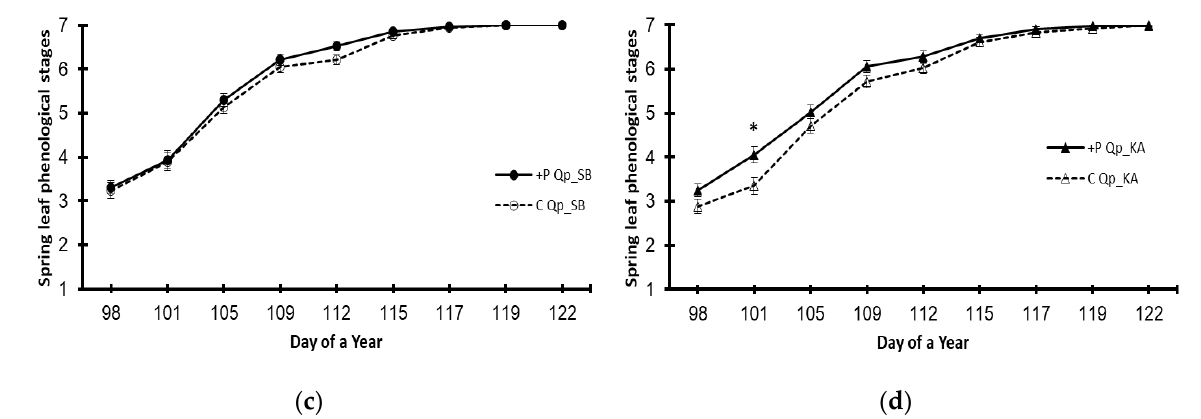
Figure 3. Spring leaf phenology of the beech (Fs) and oak (Qp) saplings in 2022 by provenance and treatment: ( a ) beech provenance SB; ( b ) beech provenance KA; ( c ) oak provenance SB; ( d ) oak provenance KA. +P treatment—elevated phosphorus; control—no phosphorus was added. The markers represent means ± S.E. ( n = 50). A star denotes a statistically significant difference between the treatments on a given day of the year ( p < 0.05).